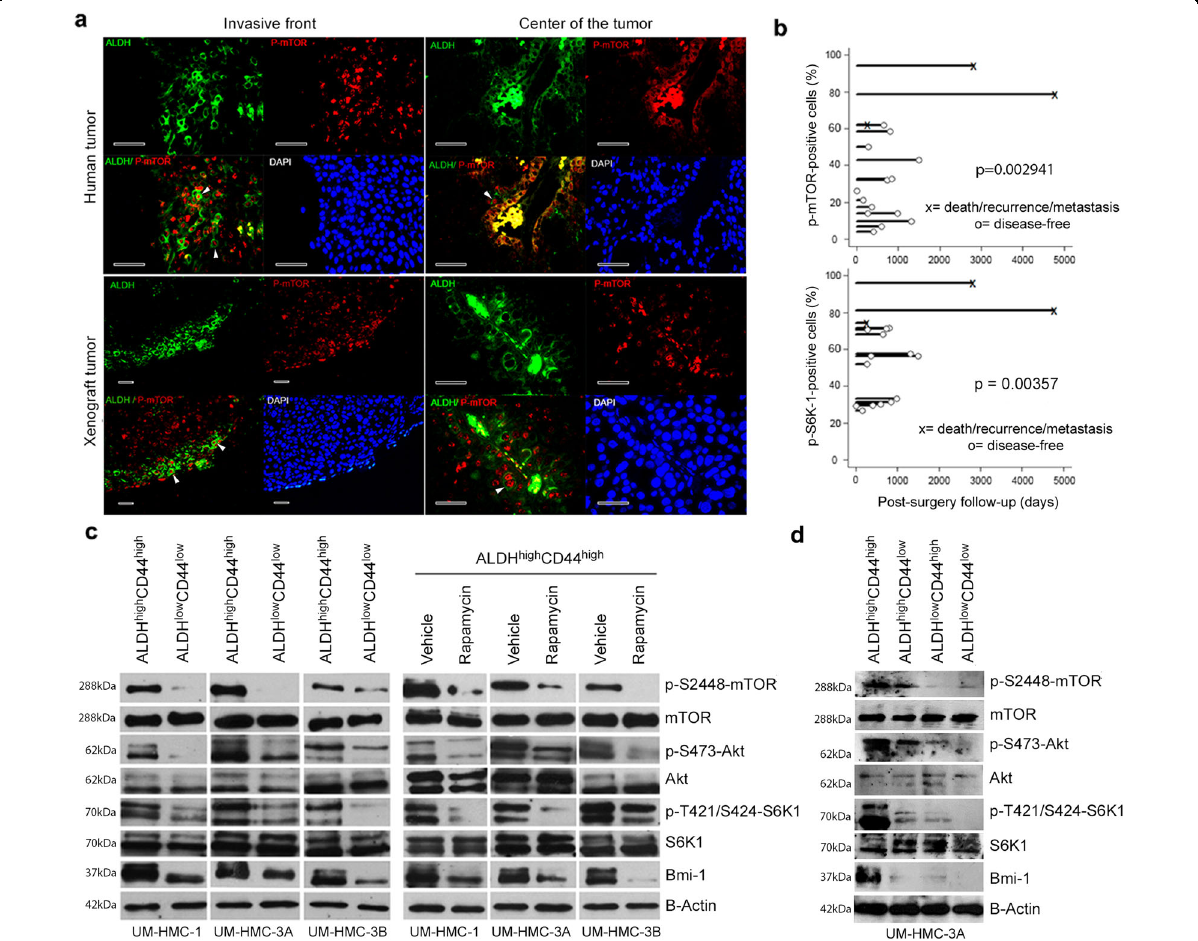
Fig. 1 mTOR pathway is constitutively active in cancer stem-like cells in human mucoepidermoid carcinomas. a Immuno fl uorescence staining of primary human salivary gland mucoepidermoid carcinoma or xenograft tumors generated from UM-HMC-3A cells. ALDH1 is stained in green, p-mTOR is stained in red and DAPI is stained in blue. Scale bars represent 25 µm. b Graphs depicting the correlation of survival of MEC patients after surgery and expression of pS6K1 and p-mTOR ( n = 17; fi ve fi elds per slide). c Western blots for AKT, p-S473-AKT, mTOR, p-S2448-mTOR, S6K1, p- T421/S424-S6K1, and Bmi-1 in ALDH high CD44 high or ALDH low CD44 low cells sorted from UM-HMC-1, UM-HMC-3A or UM-HMC-3B cells. Alternatively, ALDH high CD44 high cells (i.e., cancer stem-like cells) were exposed to 2 ng/ml rapamycin or vehicle control for 24 h. d Western blots for AKT, p-S473- AKT, mTOR, p-S2448-mTOR, S6K1, p-T421/S424-S6K1, Bmi-1 in ALDH high CD44 high , ALDH high CD44 low , ALDH low CD44 high , or ALDH low CD44 low cells